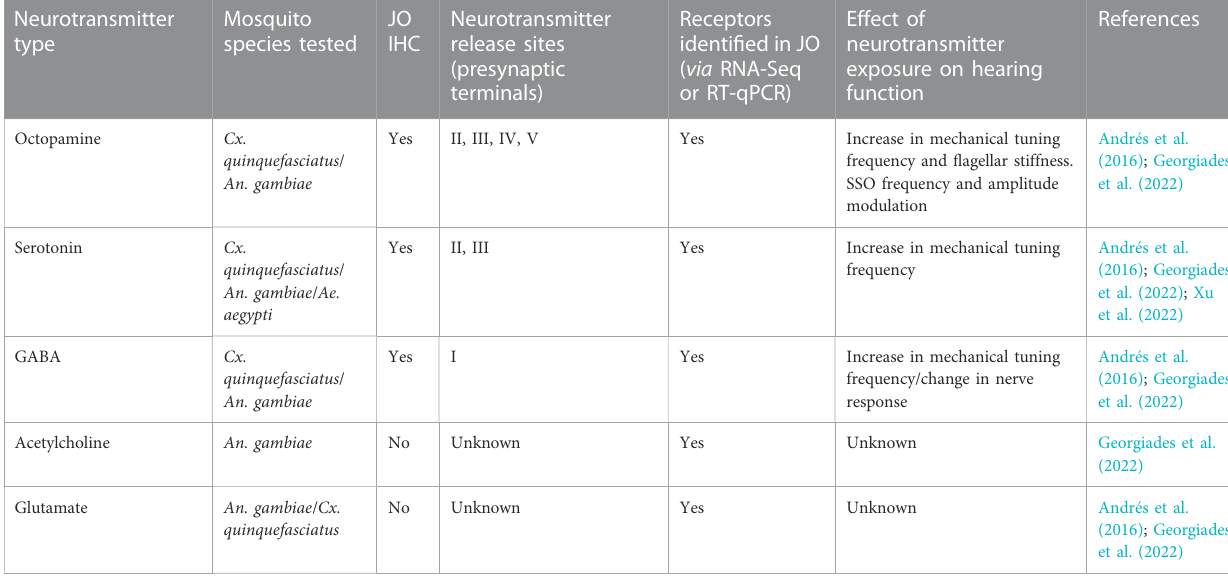
TABLE 2 Known effects of neurotransmitters on male mosquito hearing function.